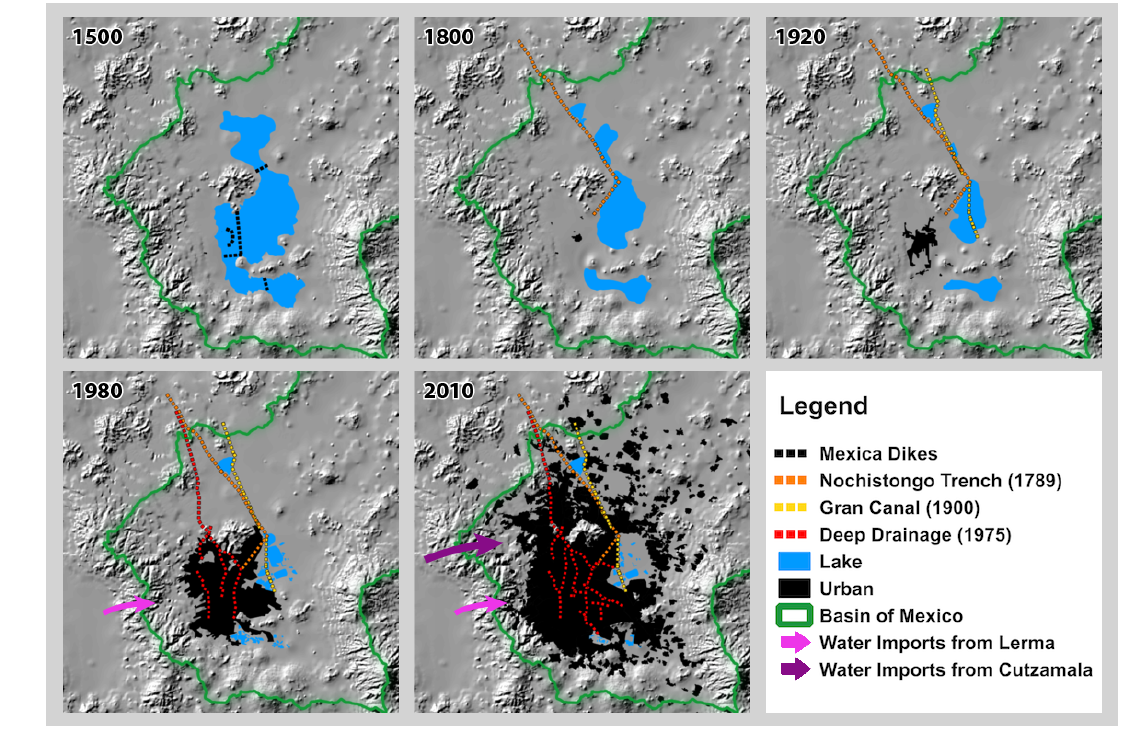
Fig. 2 . Transformation of the Basin of Mexico over time, via urban expansion, draining lakes, and investments in built infrastructure 1500-2010. Infrastructure data: Tellman hand-drew and georeferenced the Mexica Dikes and Nochistongo Trench from map by Jorge Guerria Lacroix (DDF 1975); Drainage 1920-2010 from SACMEX a ; Urban and Lake Areas courtesy of Centro Eure based on data from GEM 1993, INEGI 1980,